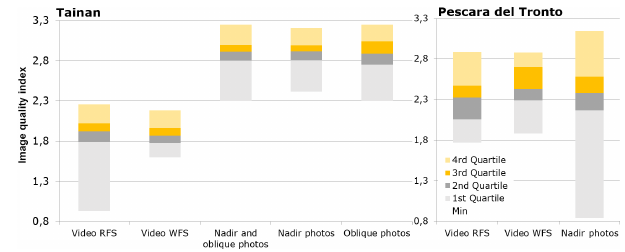
Figure 4. Box plot of the image quality index (IQI) computed for Tainan and Pescara del Tronto datasets. Table 3. Accuracy (%) of 2-D damage-related feature extraction for every dataset and study